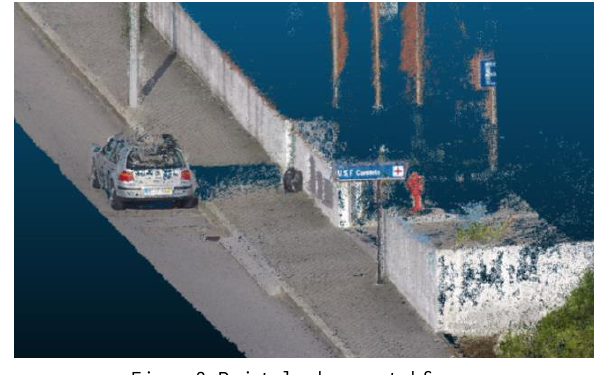
Figure 8. Point cloud generated from a sequence of video